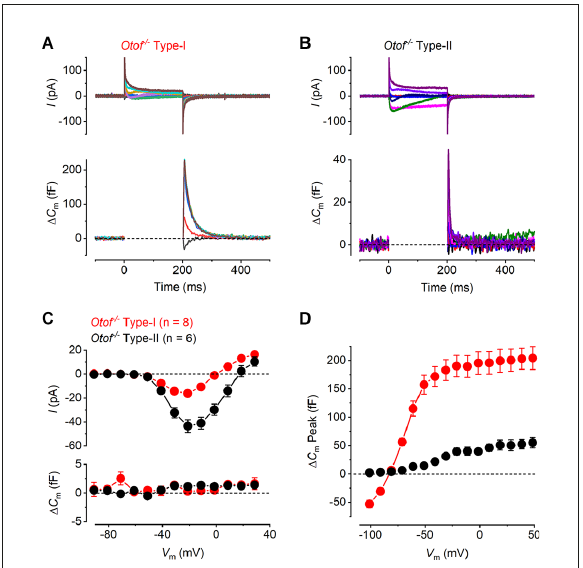
FIGURE4 Ca 2+ currents and Ca 2+ dependent exocytosis in hair cells from mature otoferlin knockout mouse utricles. (A,B) Representative I Ca (upper panels) and the corresponding ∆ C m (lower panels) from an Otof − / − type-I and an Otof − / − type-II cell, respectively, in response to the same voltage protocols used in Figures 2A,B . The I Ca was present in both hair cell types whereas the sustained ∆ C m responses were completely abolished. The transient ∆ C m responses were still present in both type-I and type-II hair cells. (C) Mean peak I-V relation (upper panel) and the corresponding mean sustained ∆ C m - V relation (lower panel) for type-I ( − 16.21 ± 1.79 pA; 0.31 ± 0.55 fF, n = 8) and type-II hair cells ( − 43.56 ± 5.34 pA, 1.13 ± 0.59 fF, n = 6) from Otof − / −